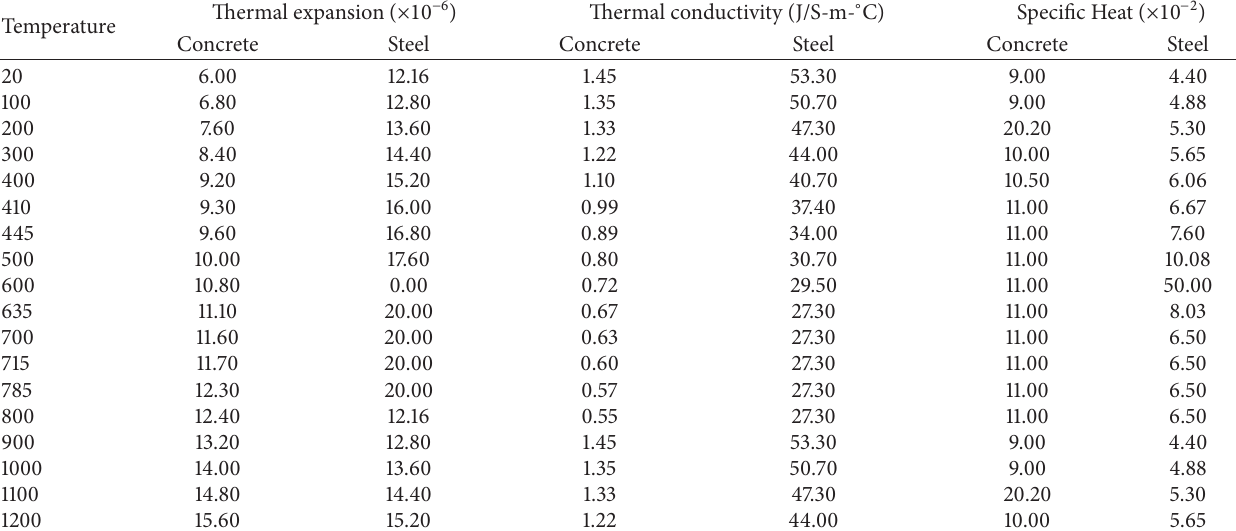
Table 2: Thermal properties of steel and concrete at elevated